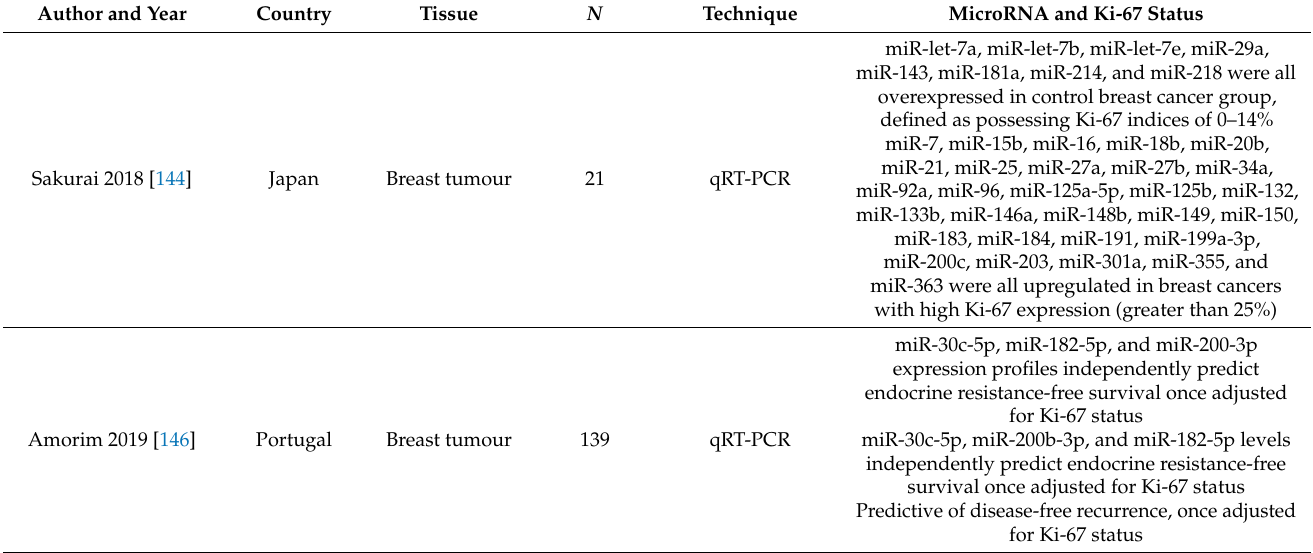
Table 2. Micro-RNA and their associations with Ki-67 proliferation index expression